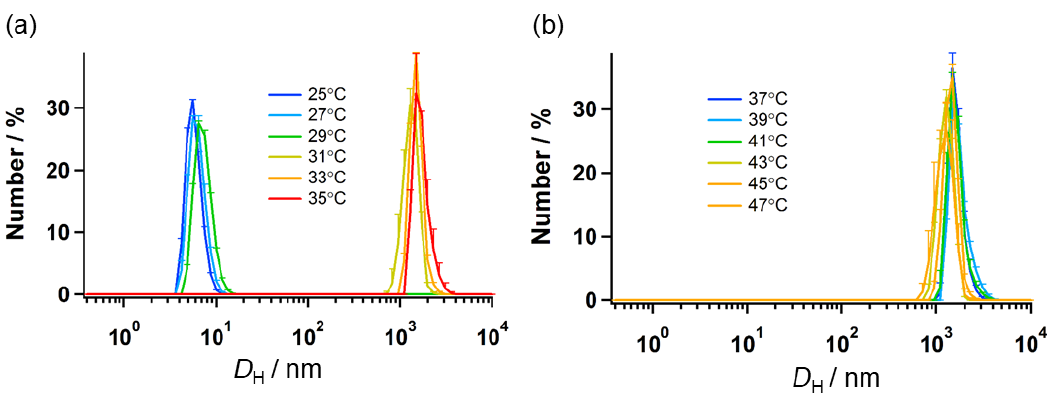
Figure 2. Size variations of the heat-triggered particles. D H values of the 5.0 mM TFMAQ-diEg4 solutions were determined using the DLS, at various temperatures. D H values are presented between ( a ) 25−35 °C, and ( b ) 37−47 °C.